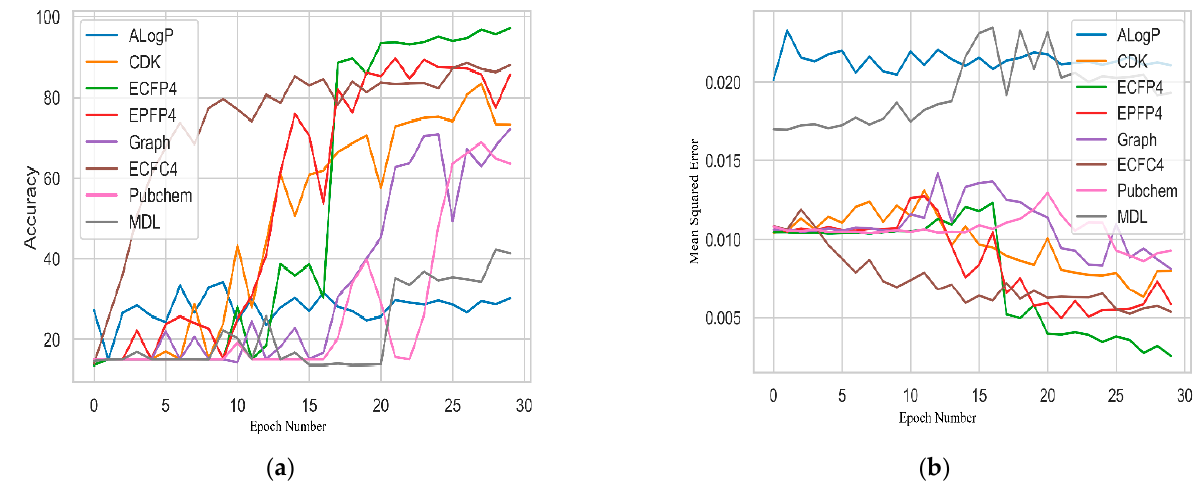
Figure 3. Evaluation of eight fingerprints based on their ( a ) accuracy and ( b ) MSE performance.